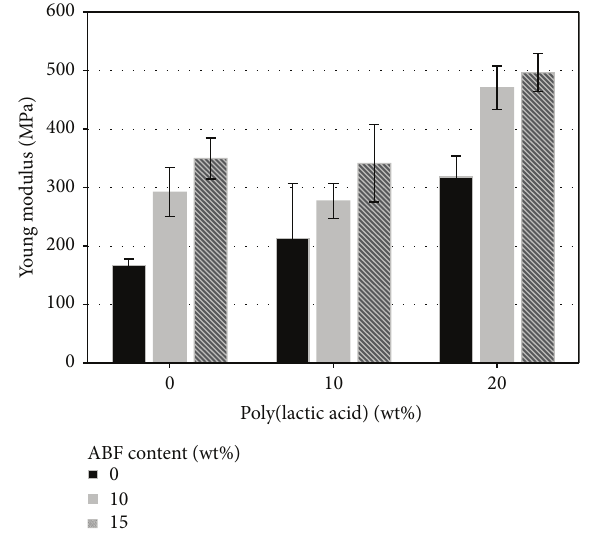
Figure 7: Young modulus of polymer blends and composites at 25 ∘ C, varying PLA content.